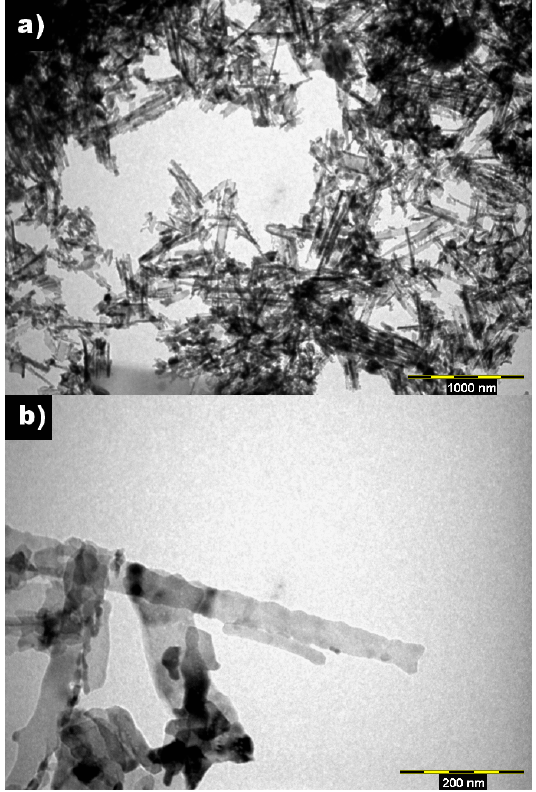
Figure 6. TEM micrograph of the ( a ) bundles and ( b ) single TiO 2 nanotubes membrane.